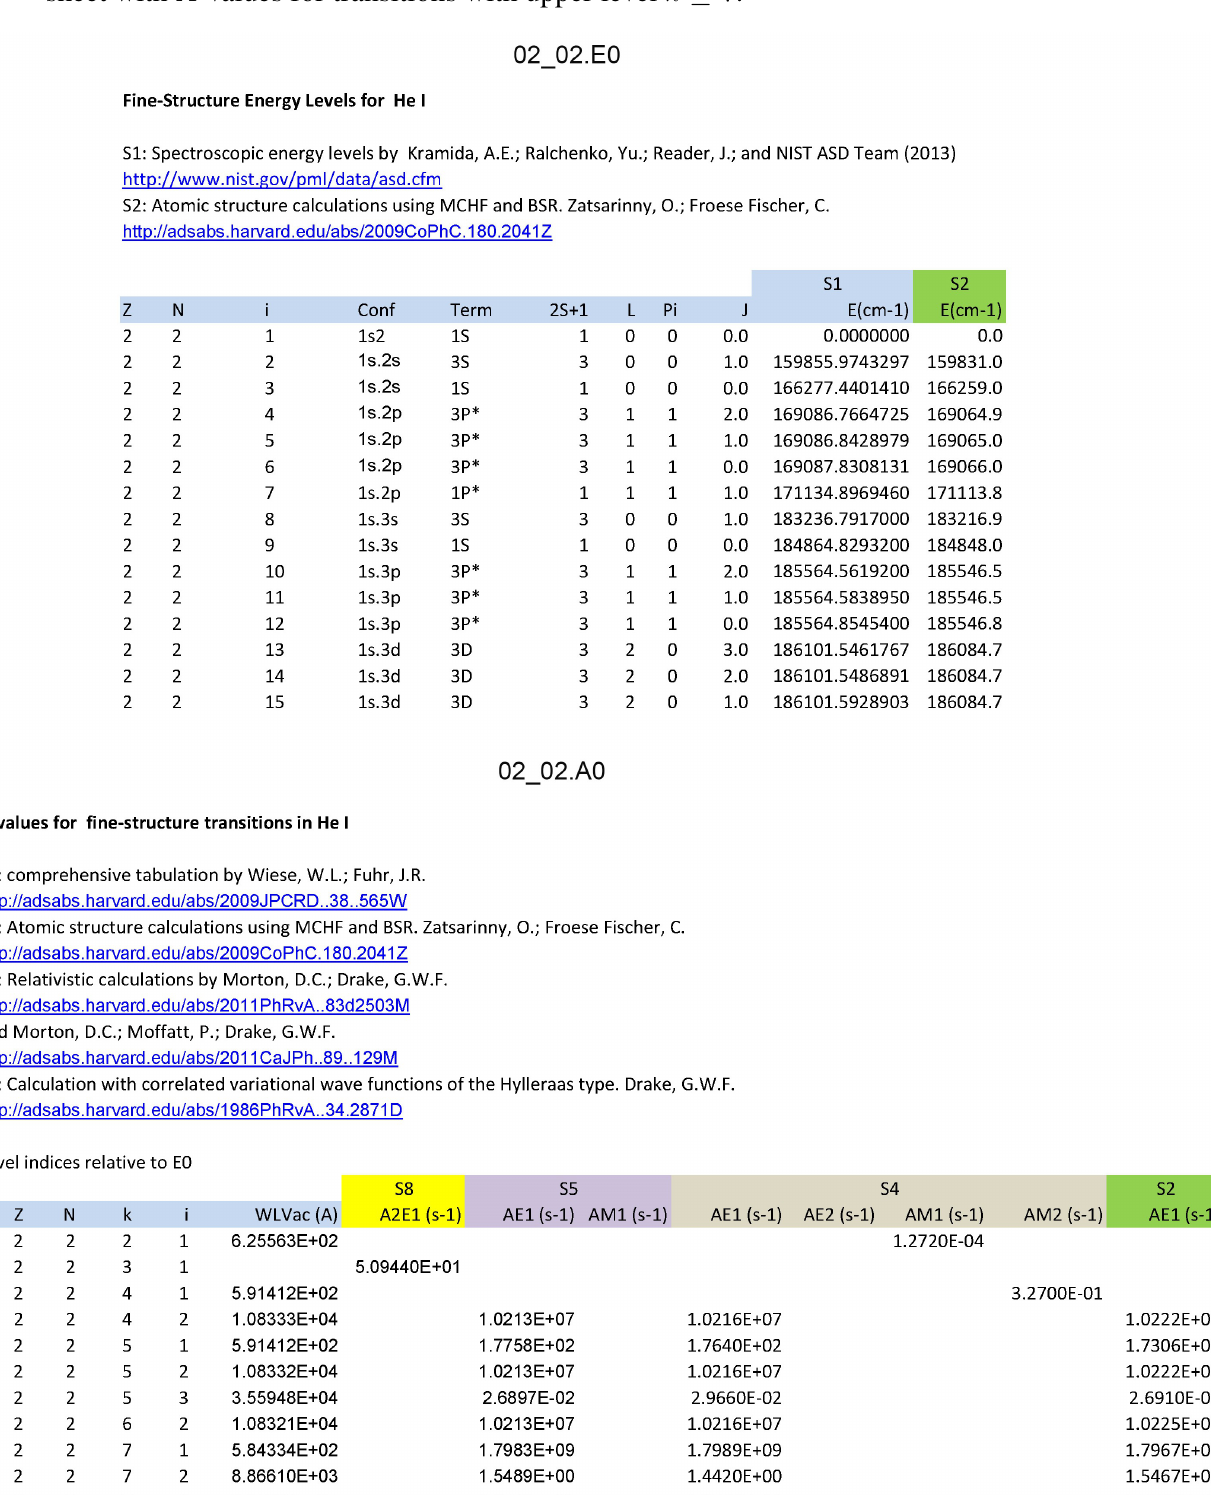
Figure 4. Workbook 02_02 for the (2 , 2) ionic system ( i.e. , He I ) showing the 02_02.E0 sheet with a 49-level atomic model (only the first 15 levels are depicted) and the 02_02.A0 sheet with A -values for transitions with upper level k ≤ 7